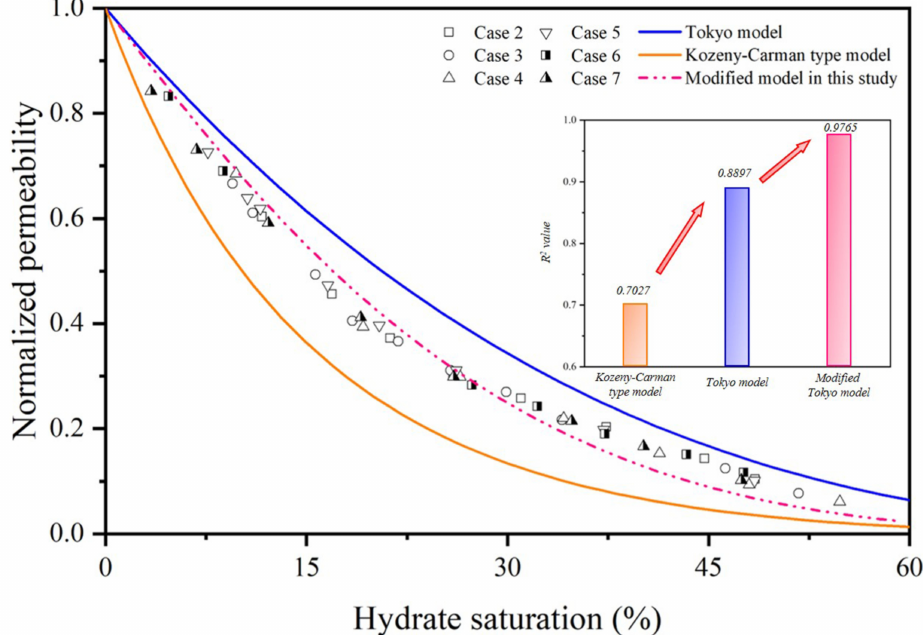
Figure 41. Comparison of normalized permeability between experimental results and permeability model predictions (The R 2 values for different models are shown in the inset) reprinted from [69] with permission from Elsevier.